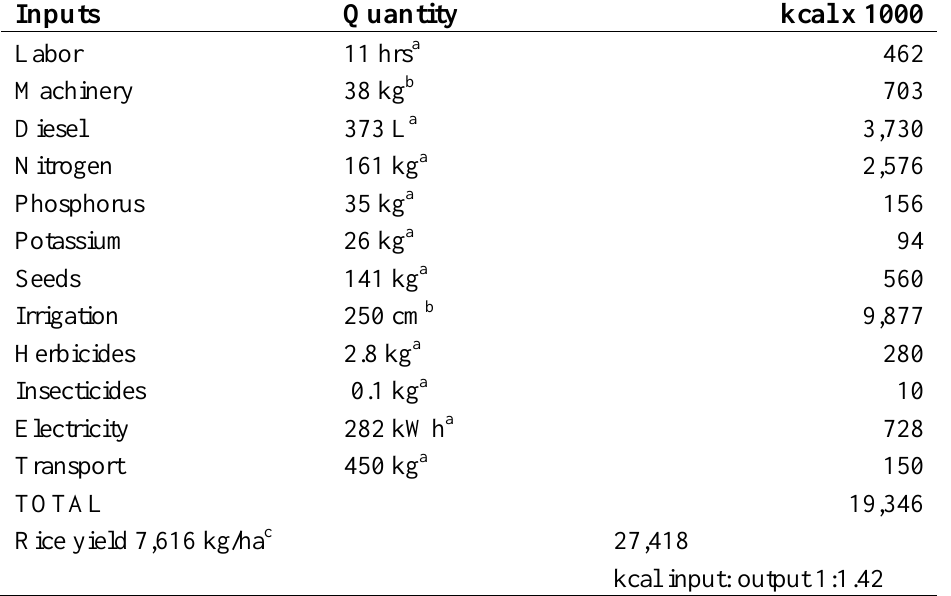
Table 9. Energy inputs of rice production per hectare in the United